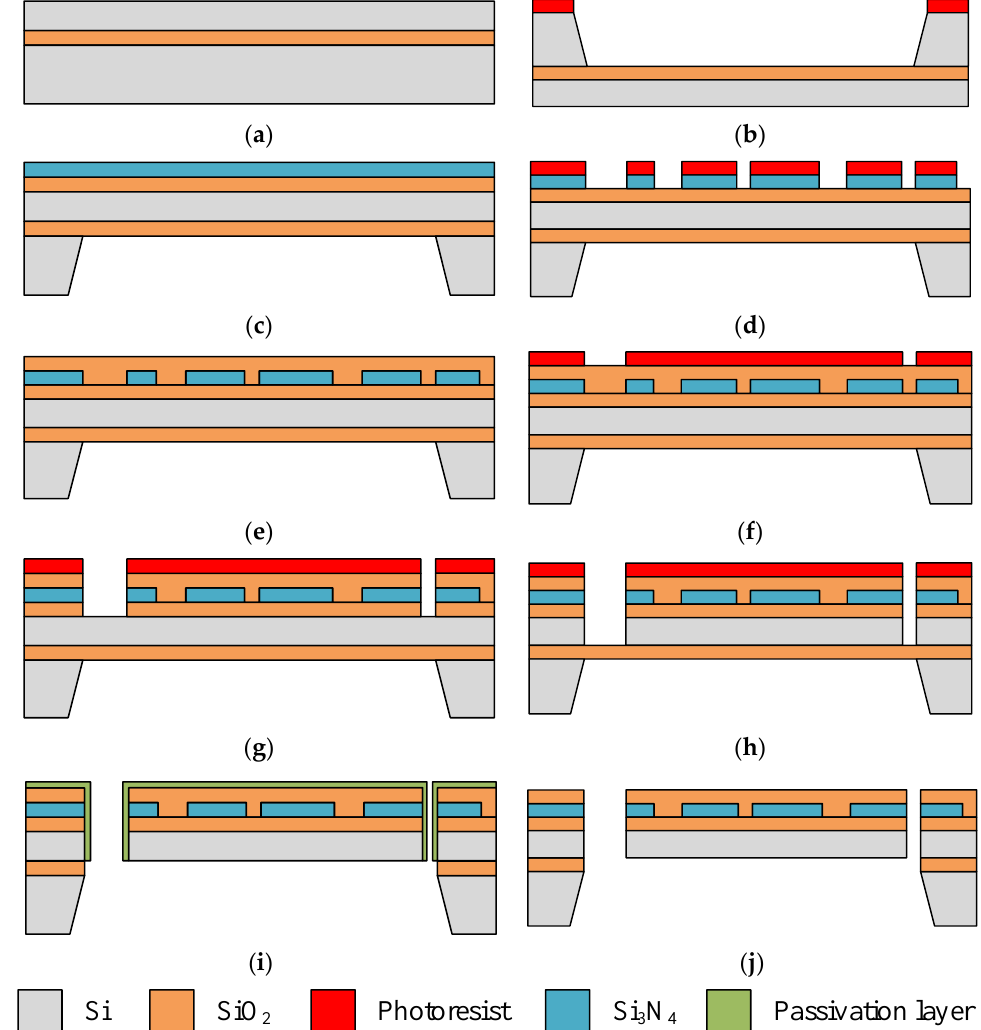
Figure 2. Technological process of a MOEM-accelerometer fabrication with single-plane waveguides. ( a ) SOI wafer; ( b ) Etching of SOI wafer handle layer; ( c ) Deposition of Si 3 N 4 and SiO 2 layers; ( d ) Etching of Si 3 N 4 ; ( e ) Deposition of SiO 2 covering layer; ( f ) Photoresist mask formation; ( g ) Etching of SiO 2 ; ( h ) Deep etching of SOI wafer device layer; ( i ) Passivation of SOI wafer and SOI BOX layer removal; ( j ) Passivation layer removal.